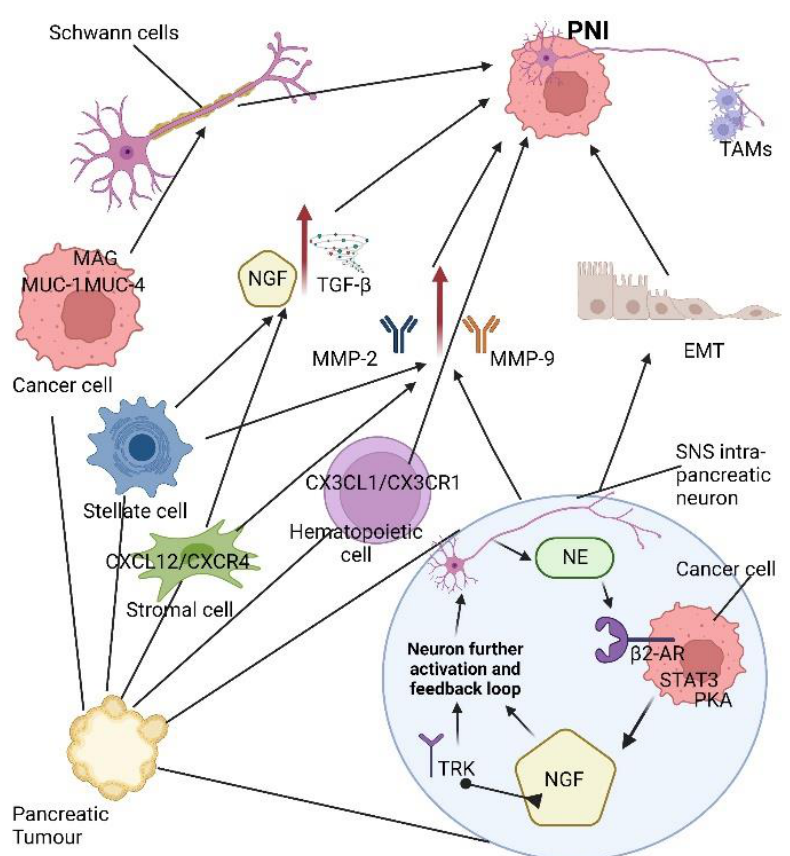
Figure 2. Perineural invasion signalling pathways in pancreatic cancer. β 2-adrinergic receptor ( β 2- AR), epithelial- mesenchymal transition (EMT), chemokine (C-X-C motif) ligand 4 (CXCL4), C-X-C motif chemokine 12 ( CXCL12 ), neural chemokine fractalkine (CX3CL1), neural chemokine fractalkine receptor (CX3CR1), matrix metalloproteinases (MMP-2, MMP-9), myelin-associated glycoprotein (MAG), nerve growth factor (NGF), norepinephrine (NE), protein kinase A ( PKA ), signal transducer and activator of transcription 3 (Stat3), sympathetic nervous system (SNS) transforming growth factor beta (TFG- β ),transmembrane mucins (MUC-1 MUC-4), tyrosine kinases receptor (TRK), tumour associated macrophages (TAMs).